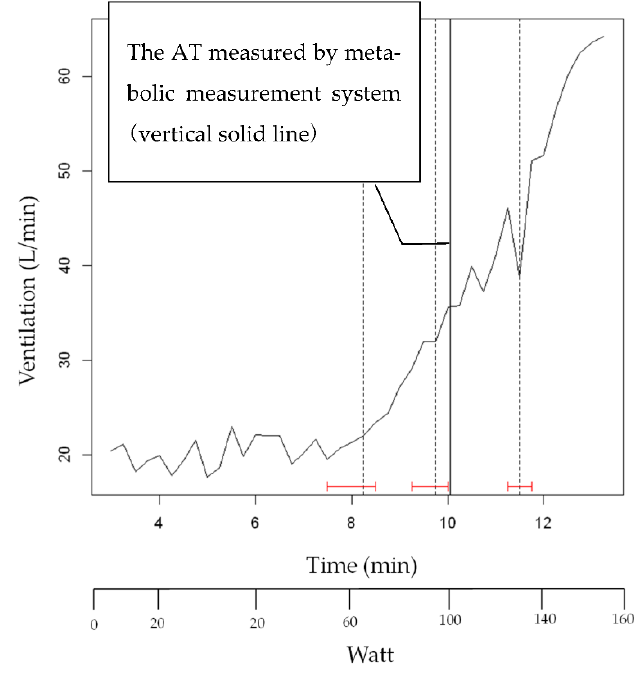
Figure 7. The results of the strucchange results of VE (subject K) after smoothing.